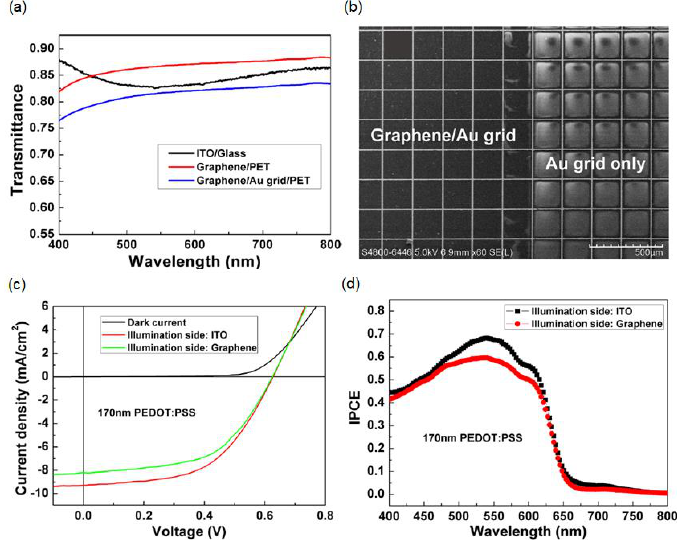
Figure 3. ( a ) Transmission spectra of three different electrodes: ITO/glass, monolayer graphene/PET, and monolayer graphene/Au grid/PET; ( b ) Top-view SEM image of the monolayer graphene/Au grid hybrid transparent electrode, where the size of the Au grid is 200 µ m × 200 µ m; ( c ) J – V characteristics and ( d ) incident-photon-to-electron conversion efficiency (IPCE) spectra of the semitransparent organic solar-cell devices measured under illumination from both sides of the semitransparent devices with a PEDOT:PSS thickness of 170 nm. Reproduced with permission [87]. Copyright 2013, American Physical